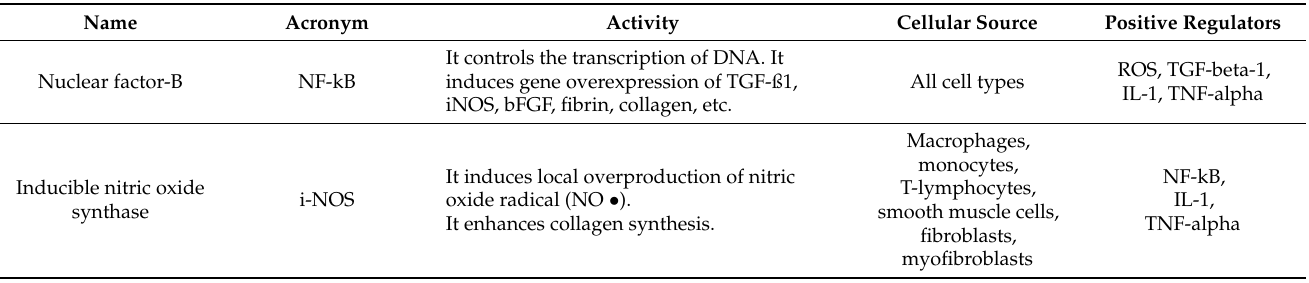
Table 1. List of major biological mediators (and their properties) involved in Peyronie’s disease. Useful table for the choice of a possible “targeted antioxidant